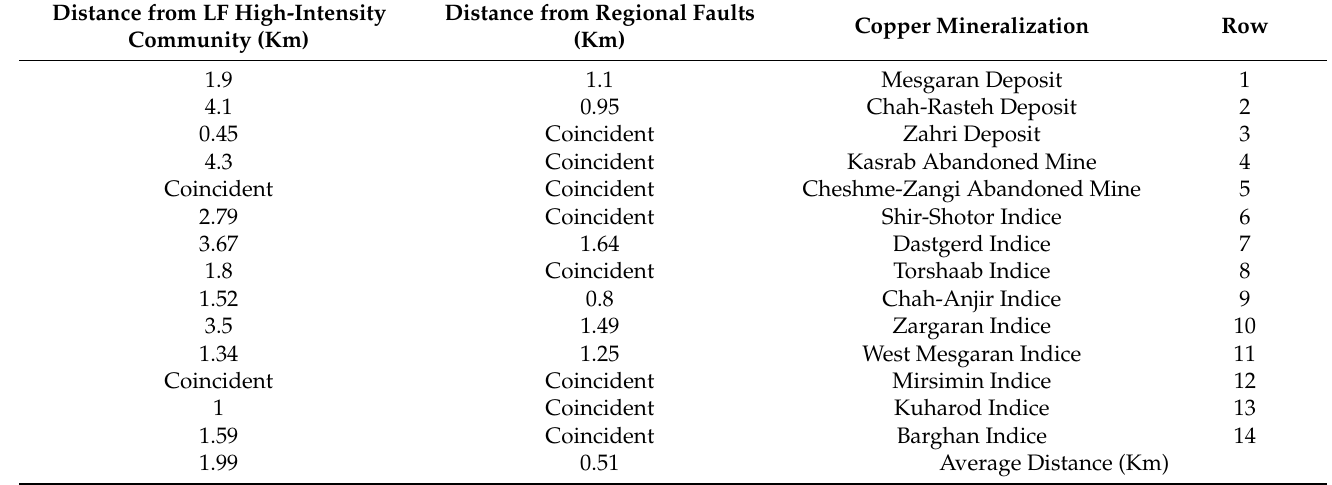
Table 3. Copper mineralization distance from regional faults and LF high-intensity community.